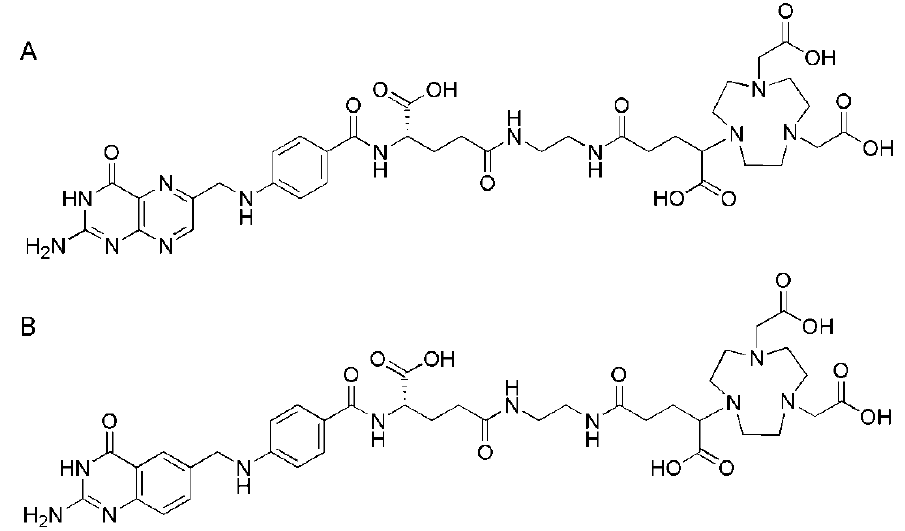
Figure 10. ( A ) Chemical structure of the NODAGA-folate P3246 [51] and ( B ) the NODAGA-dideaza-folate P3238